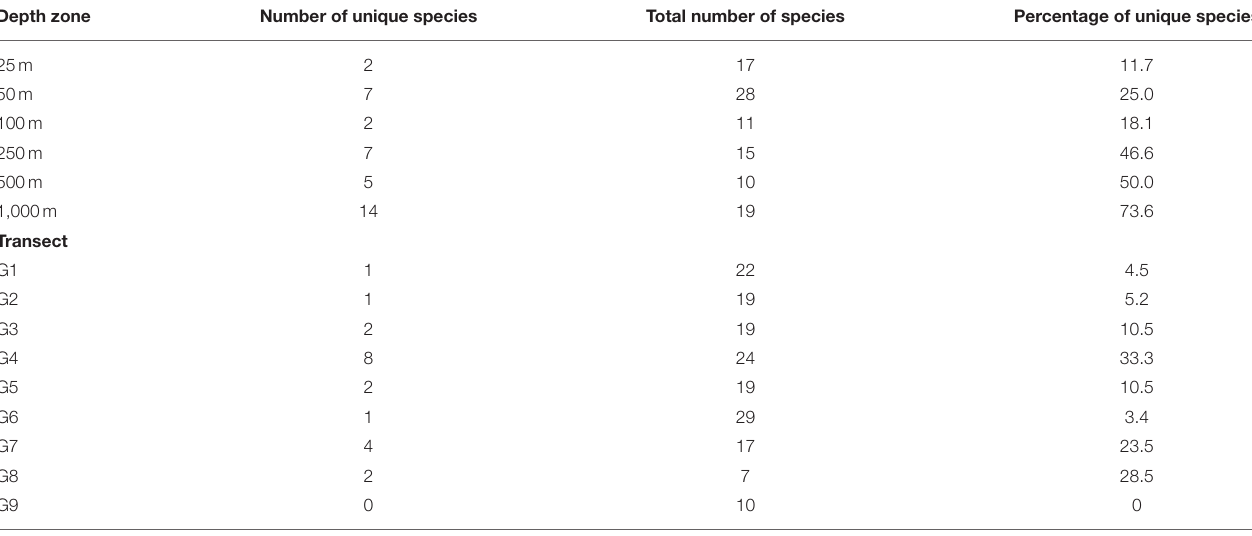
TABLE 2 | Total number of species in each depth zone/transect and number of species recorded only in a given depth zone/transect.